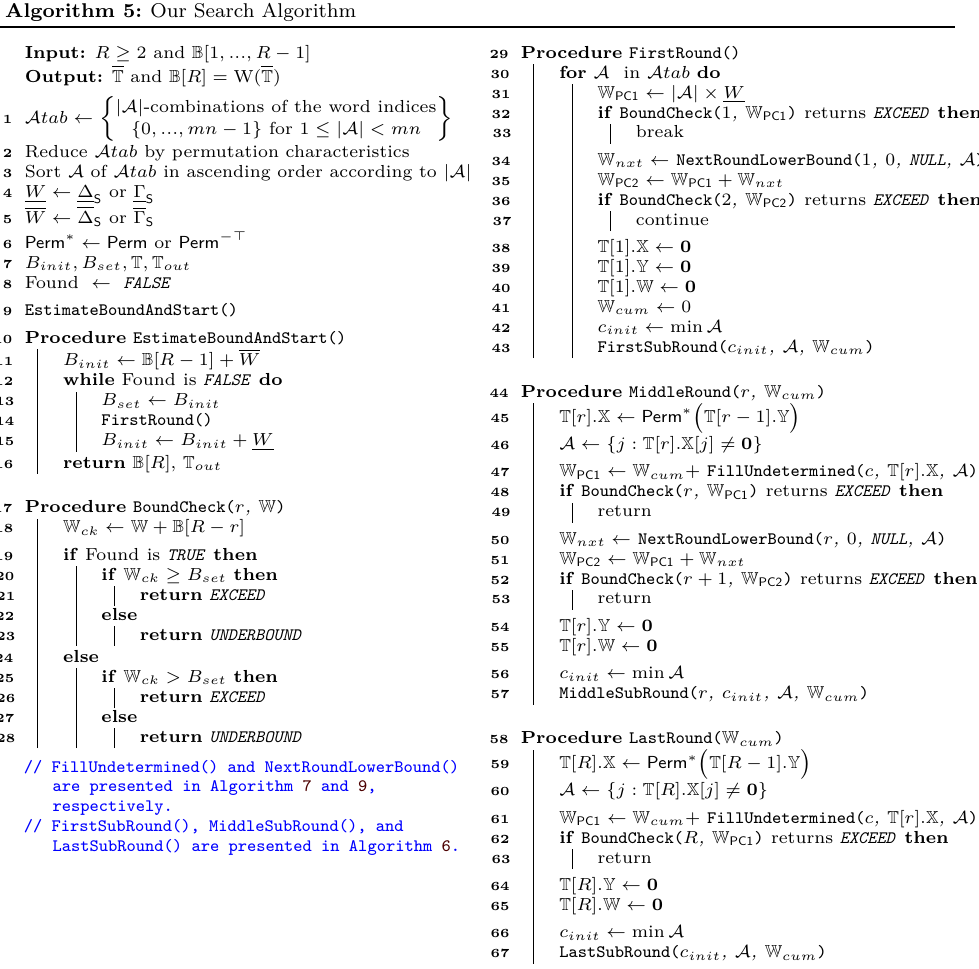
Algorithm 5: Our Search